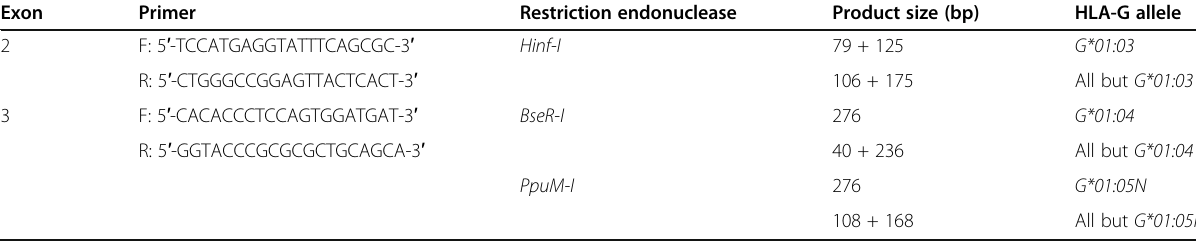
Table 2 Assignment of HLA-G*01:03 , HLA-G*01:04 , and HLA-G*01:05N alleles [25]